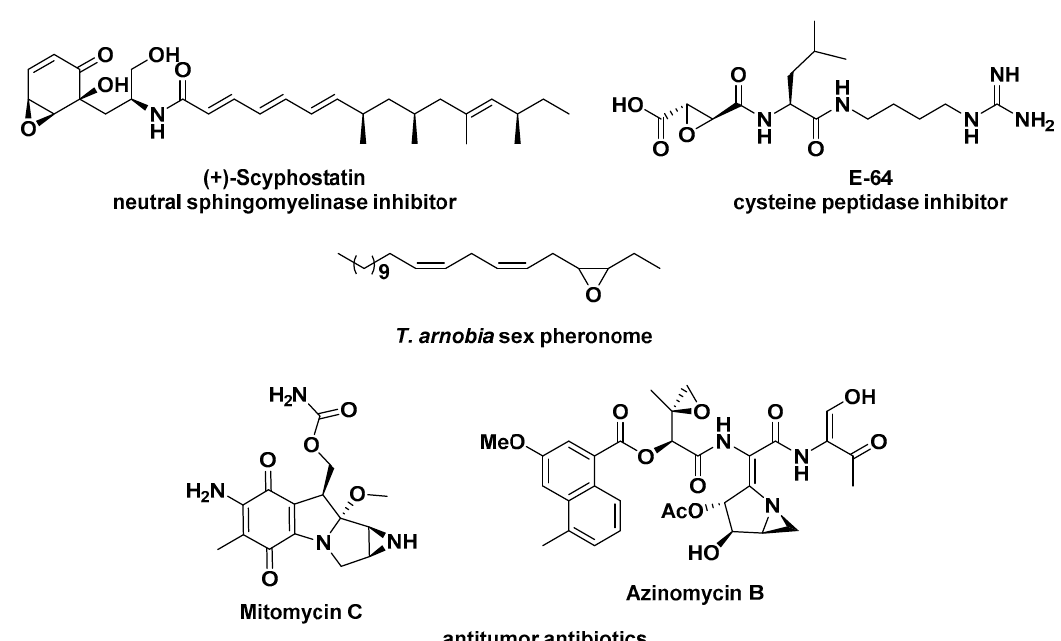
Figure 1. Examples of natural products possessing epoxide and aziridine rings.